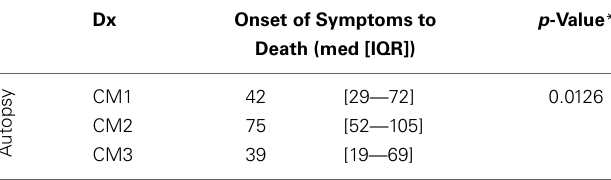
Table 1 | The time (hours) from onset of symptoms (based on history from parents/guardians) to death for all fatal cases in the study for which there was autopsy ( n = 103) data available demonstrate that CM1 cases appear to be a shorter duration of illness than CM2 patients consistent with our observations of the histopathology.